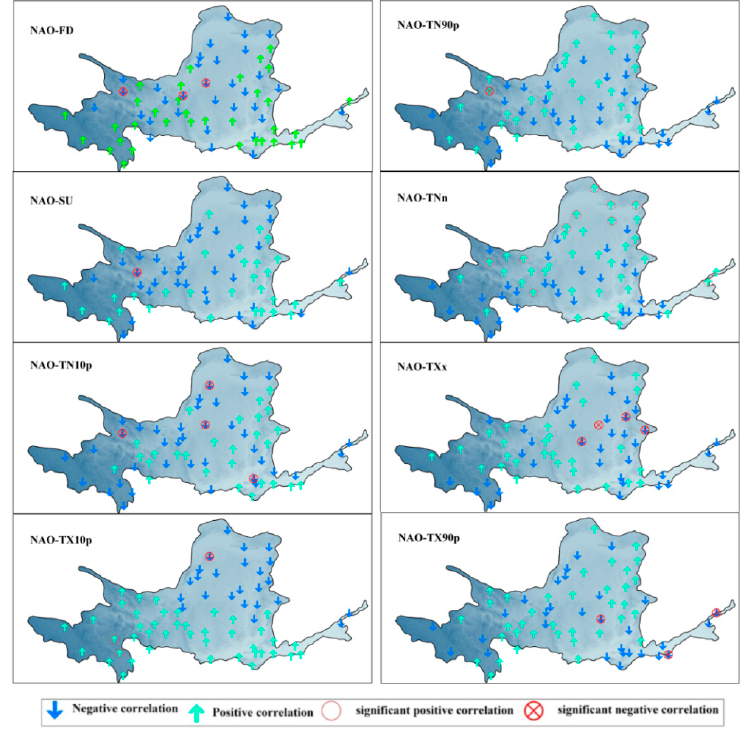
Figure 6. The potential connection between temperature extremes and the North Atlantic Oscillation